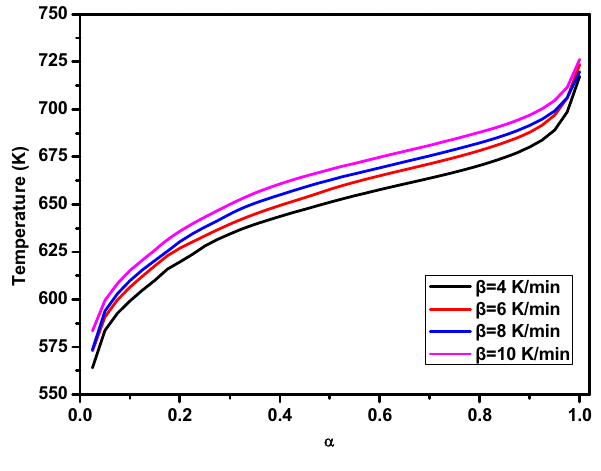
Figure 3: Thermal decomposition T – a curves of polyacrylate PSA at di ff erent heating rates.